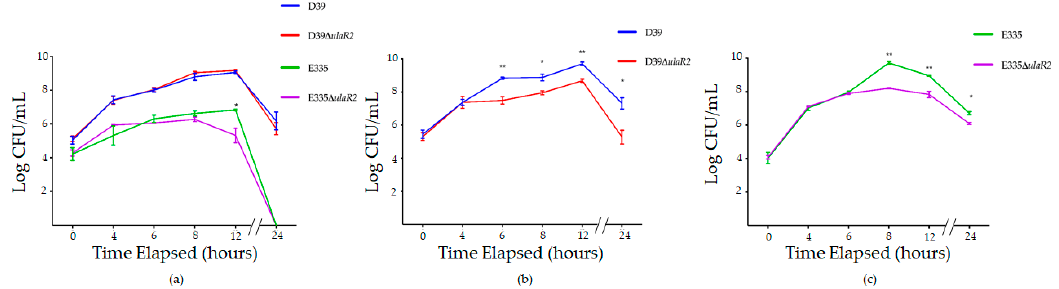
Figure 1. Growth of D39, E335, and corresponding ulaR2 isogenic mutants in vitro. ( a ) Growth of all strains in THY; ( b ) growth of D39 and D39 ∆ ulaR2 in rabbit vitreous humor. ( c ) Growth of E335 and E335 ∆ ulaR2 in rabbit vitreous humor. Bacterial growth is expressed in Log 10 units. Asterisks indicate the following: * p < 0.05, ** p < 0.01. Error bars represent standard errors of the means.